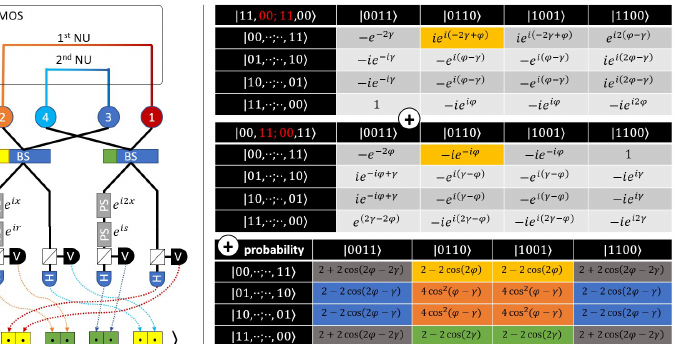
Figure 4. Diagram showing ( left ) the optical path and ( right ) the tables of coefficients for the two states corresponding to the